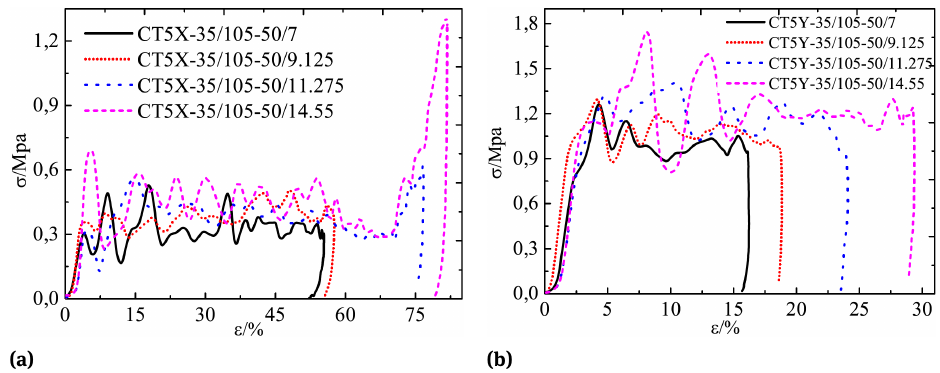
Figure 11: Influence of impact block mass on compression curves: (a) X- and (b) Y-direction regular pentagon paper corrugation tubes